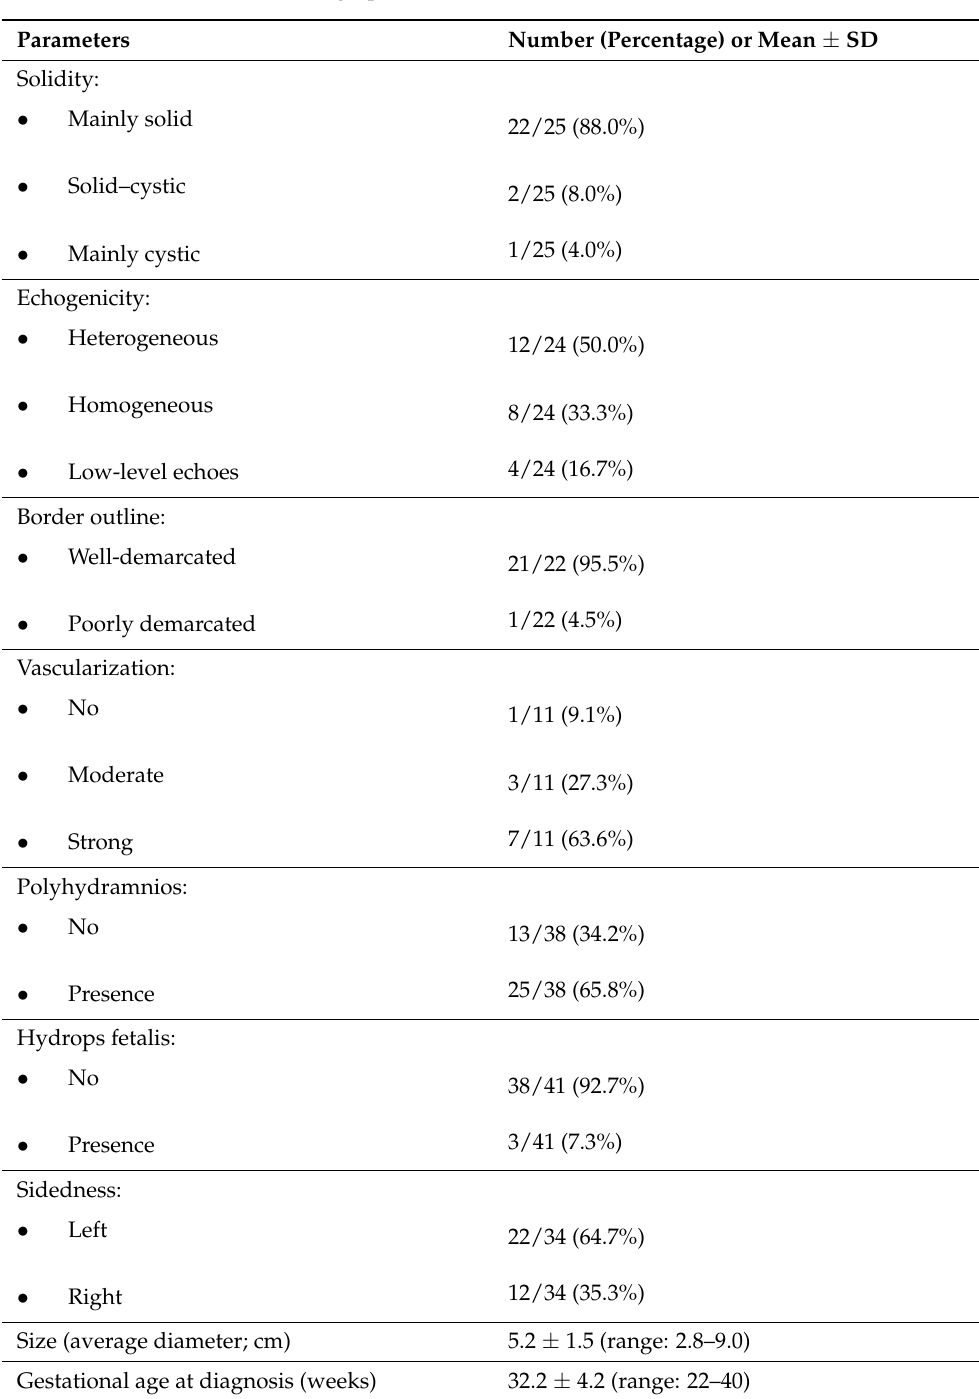
Table 2. Prenatal course and sonographic